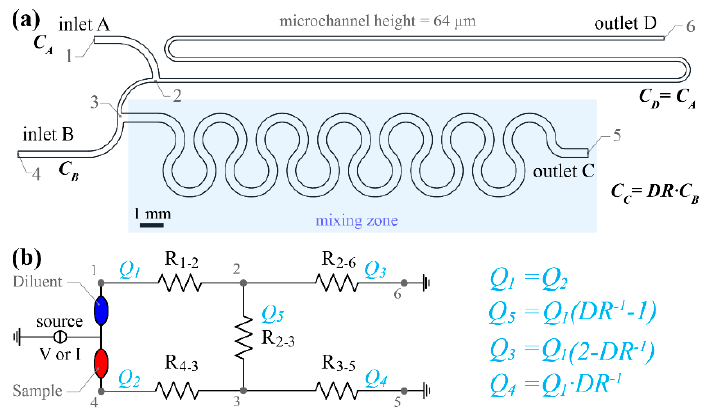
Figure 1. Serial diluter pressure and flow rate balanced unit cell. ( a ) Optimised design to generate dilution ratio DR = 2:3. If sample is supplied through inlet B at concentration C B the concentration of the diluted sample at out C will be C C = DR · C B ( b ) Microfluidic network hydraulic resistance analogous electrical circuit. The designed flowrate is 0.4 μ L/min. The sample is assumed to enter from inlet B.